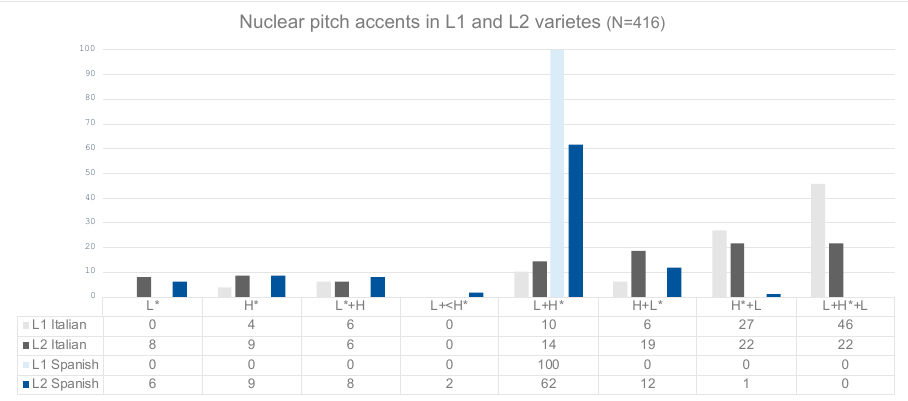
Figure 14. Tonal patterns of nuclear pitch accents found in all L1 and L2 data (in %).